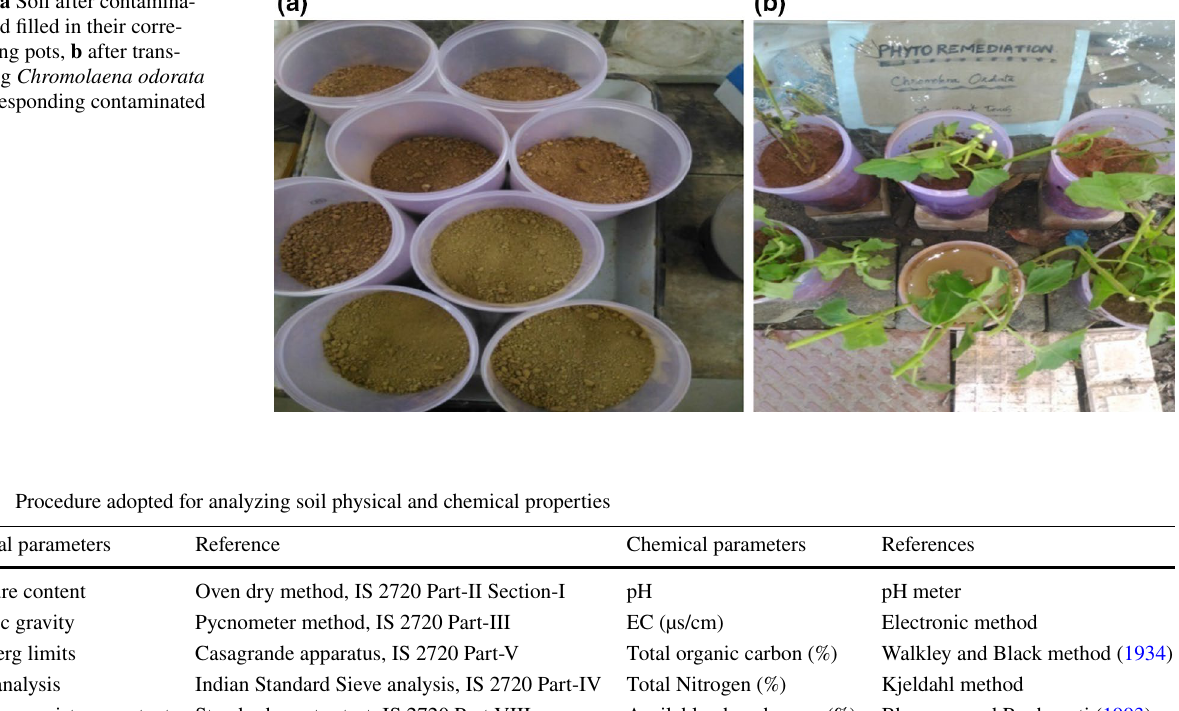
Fig. 1 a Soil after contamina- tion and filled in their corre- sponding pots, b after trans- planting Chromolaena odorata in corresponding contaminated soil